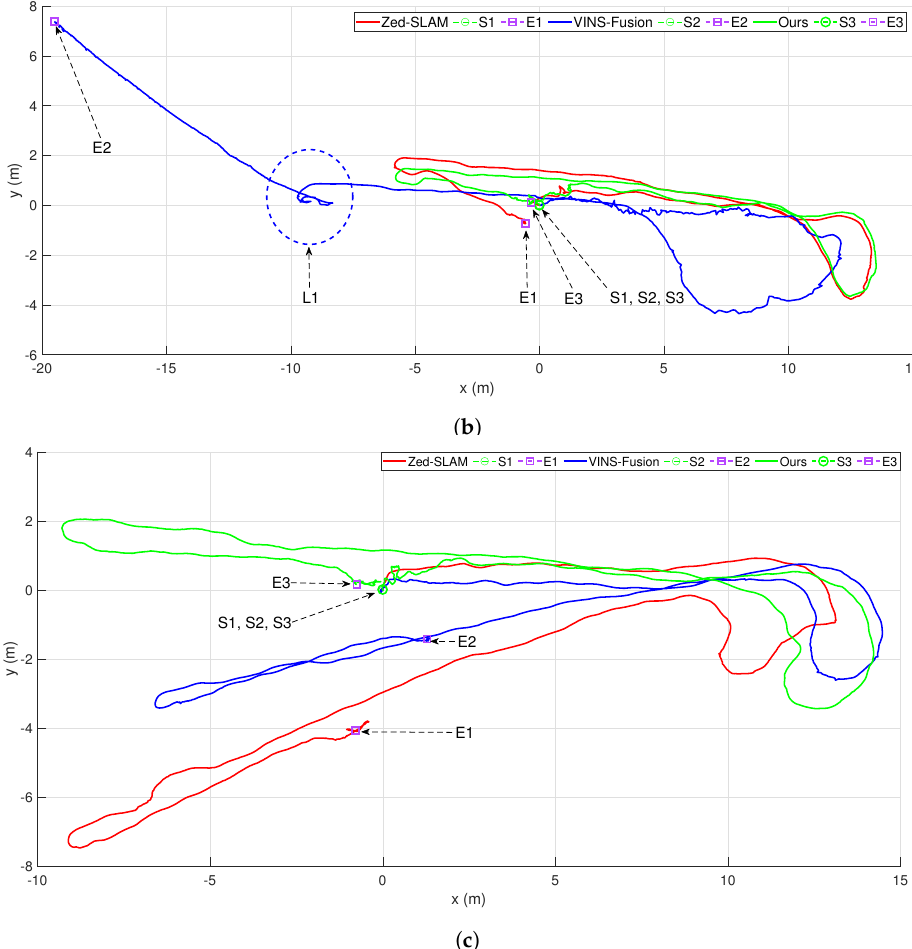
Figure 16. The comparison of estimated trajectories between our proposed method with VINS-Fusion and Zed SLAM in various situations, as described in Figure 15. ( a ) The result in scenario 1. ( b ) The result in scenario 2, where L1 lost the tracking area. ( c ) The result in scenario